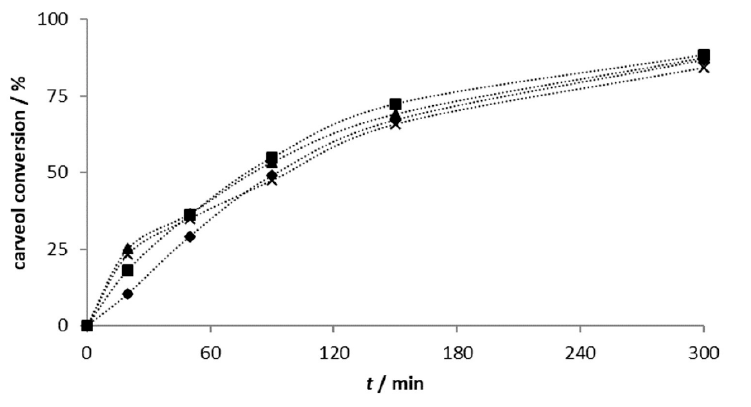
Figure 2. Converted carveol vs. time with molybdenum(VI) (pre)catalyst ♦ complex 1 , ■ complex 1a , ▲ complex 2 , × complex 2a . Conditions: n (Mo): n (substrate): n (H 2 O 2 ) = 1:400:800, T = 353 K.